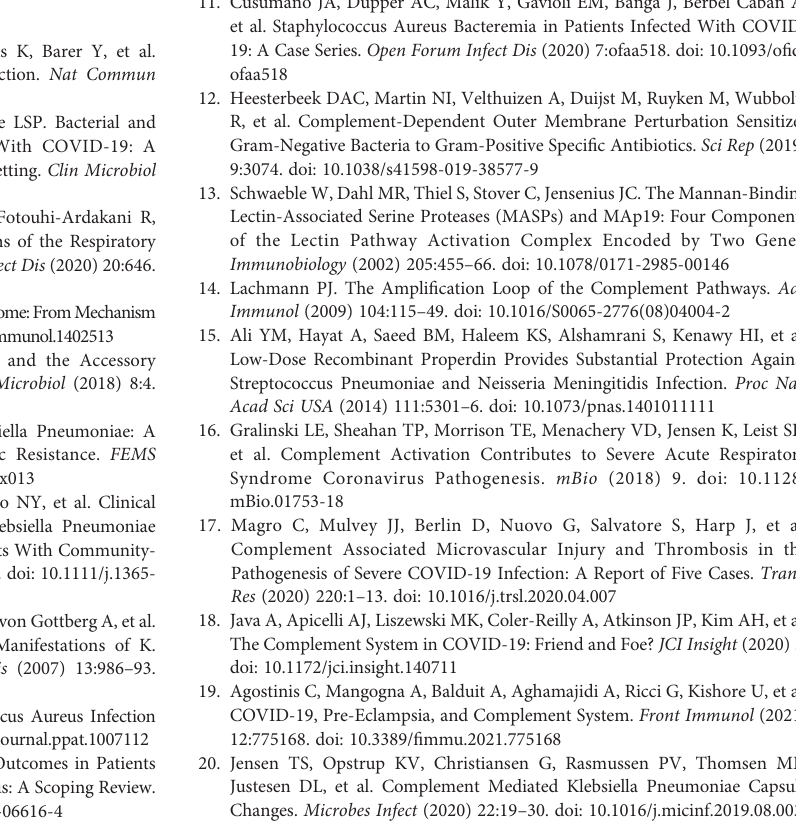
Supplementary Figure 1 | Heparin has no effect on complement activation at a concentration up to 10 IU/ml. NHS and heparinised plasma (10 IU/ml) or EDTA plasma (10 m M) were serially diluted in BBS ++ and incubated in ELISA plates coated with K. pneumoniae . Complement C3b (A) and C4b (B) deposition were measured as described in materials and methods. No signi fi cant differences were observed in the degree of C3b and C4b deposition on K. pneumoniae when using NHS or plasma collected in heparin or EDTA tubes. The haemolytic activity of NHS and heparin or EDTA plasma was measured as described in materials and methods (C) . This assay provides an end-to-end measurement of complement activation via the CP, including components that are shared in all three pathways. No signi fi cant difference was observed in the haemolytic activity between serum and heparinised plasma used in this